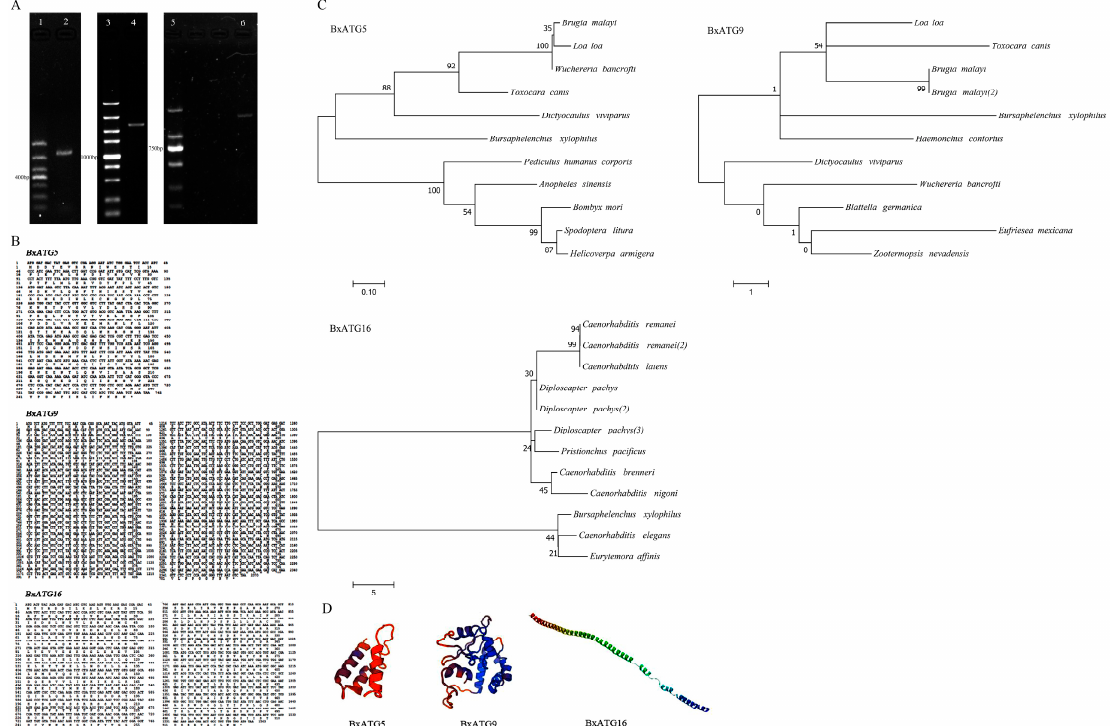
Figure 1. Cloning and sequence analysis of the autophagy genes BxATG5, BxATG9, and BxATG16 in pine wood nematodes (PWN). ( A ) Agarose gel electrophoresis of the coding sequences of BxATG5, BxATG9, and BxATG16. 1: DL1000 DNA Marker; 2. BxATG5; 3. DL5000 DNA Marker; 4. BxATG9; 5. DL2000 DNA Marker; and 6. BxATG16. ( B ) Coding sequences and deduced amino acid sequences